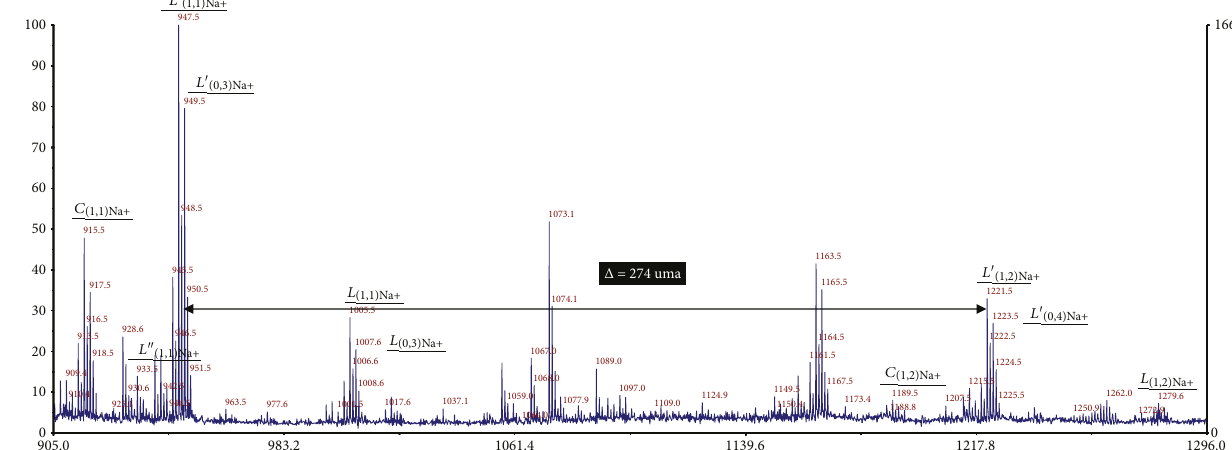
Figure 7: The MALDI-TOF MS spectrum of PBDA Ss . L x , y corresponds to linear species oligomer containing hydroxyl end groups with x 70 30 and y fatty acid and sulfonated repeating units. C x , y corresponds to cyclic species oligomer with x and y fatty acid and sulfonated repeating units. L x , y ′ corresponds to linear species oligomer containing ester end groups with x and y fatty acid and sulfonated repeating units. L x , y ″ corresponds to linear species containing acid end groups with x and y fatty acid and sulfonated repeating